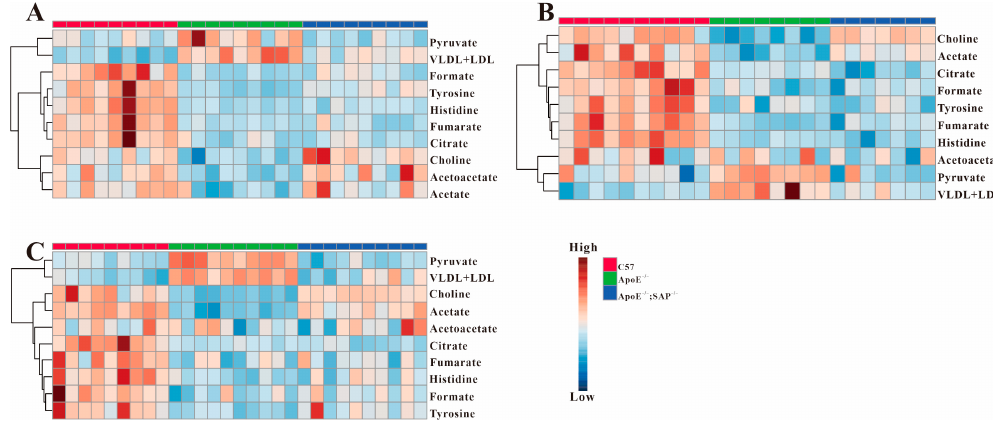
Figure 6. Heatmaps of all metabolic features in three groups. ( A ) metabolic profiles at 8 w; ( B ) metabolic profiles at 8 + 4 w and ( C ) metabolic profiles at 8 + 8 w.